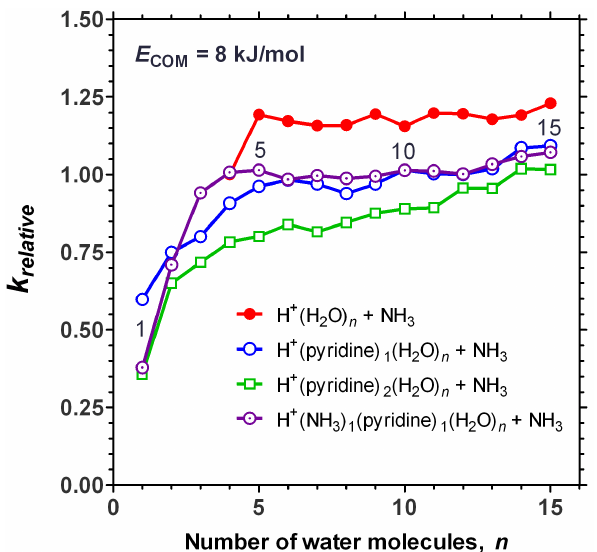
Fig. 6. Relative reaction rate coefficients for clus- ter ions H + (pyridine) m (H 2 O) n (with m = 0 to 2) and H + (NH 3 ) 1 (pyridine) 1 (H 2 O) n , reacting with NH 3 at E COM = 8kJmol − 1 . The rate coefficients are normalized to the rate coefficient for H + (H 2 O) 4 reacting with NH 3 (1.91 × 10 − 9 cm 3 s − 1 at 298K (Viggiano et al., 1988a)). The numbers 1, 5, 10, 15 indicate the number of water molecules to improve readability.